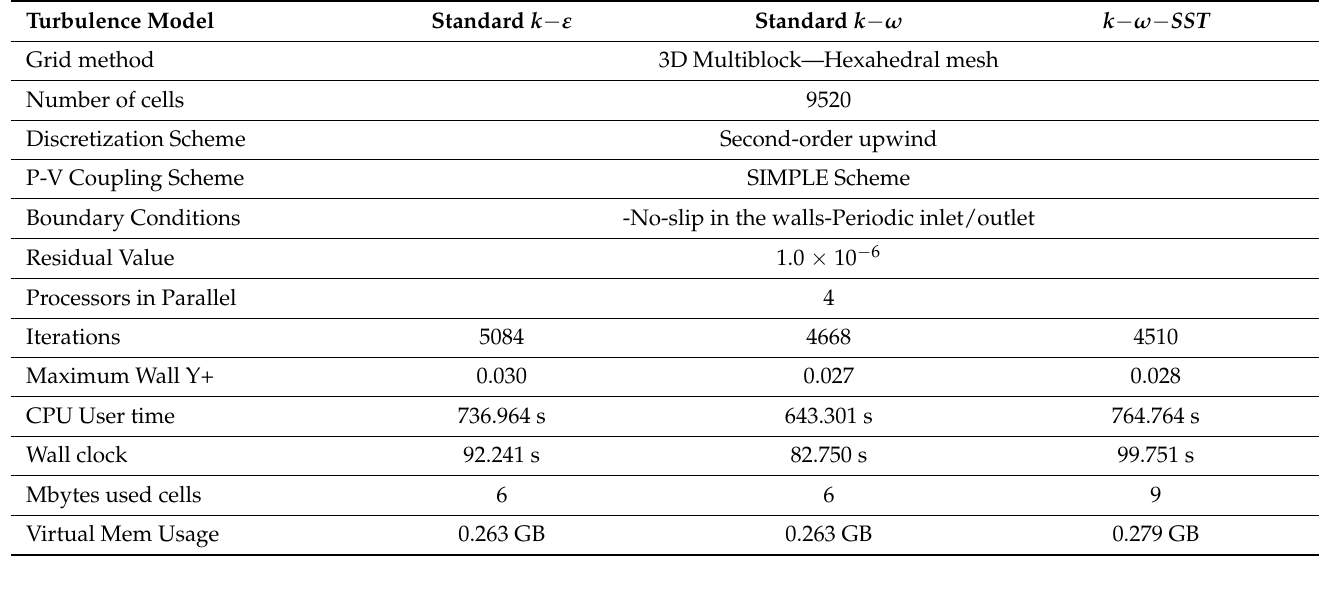
Table 5. Comparative table of turbulence models tests.